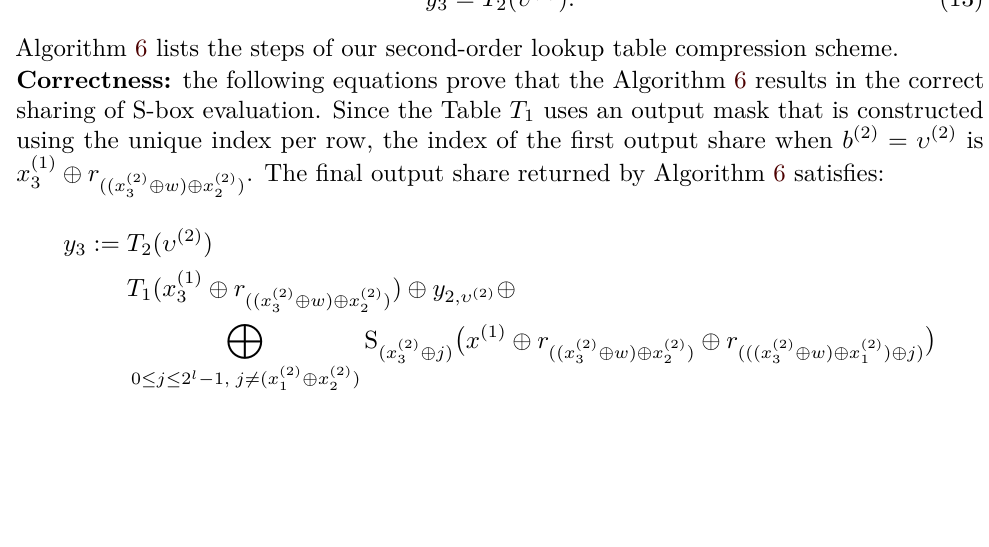
Algorithm 6 lists the steps of our second-order lookup table compression